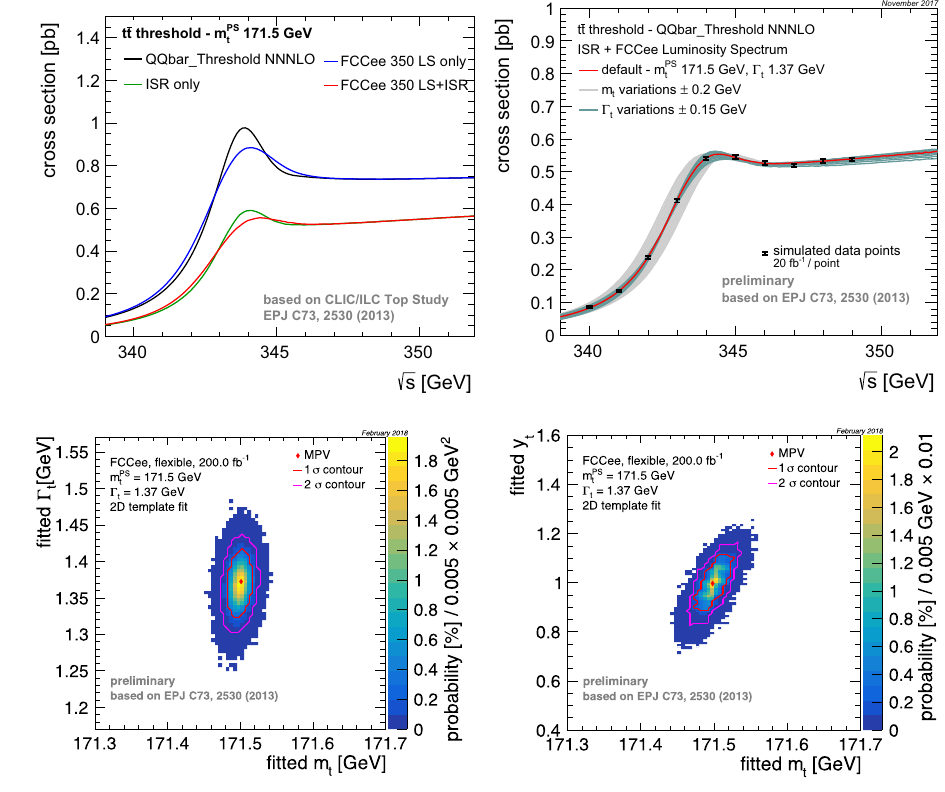
Fig. 6.1 Production cross section of top quark pairs (left) in the vicinity of the production threshold, with different values of the masses and widths